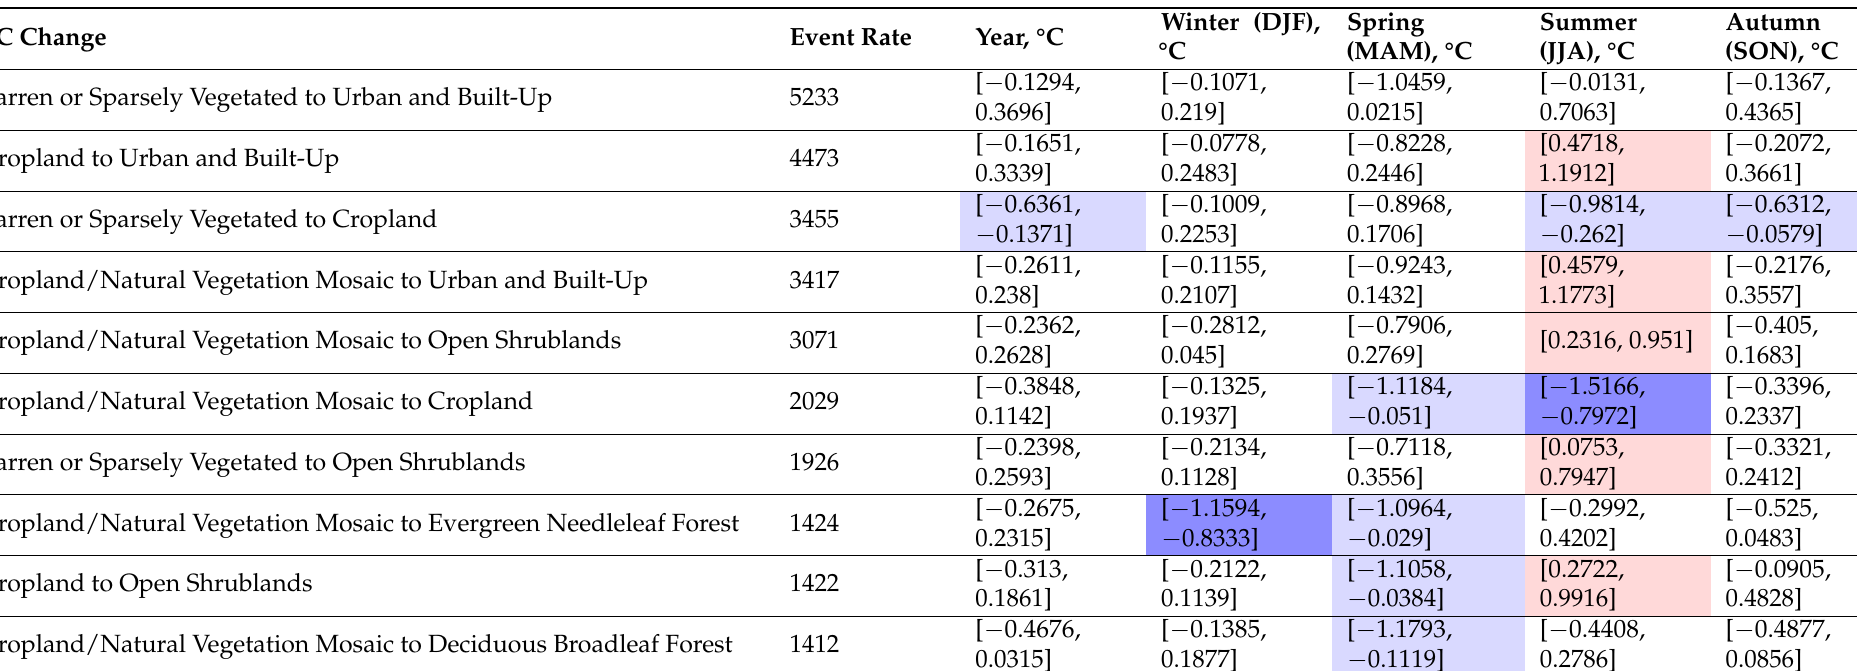
Table A3. Temperature changes in southern Europe depending on LC transformation. Blue and red cells represent LC changes resulting in statistically significant cooling and warming, respectively. Intense blue and red cells show cells where LC changes resulted in at least a 0.5 °C temperature change with 95%